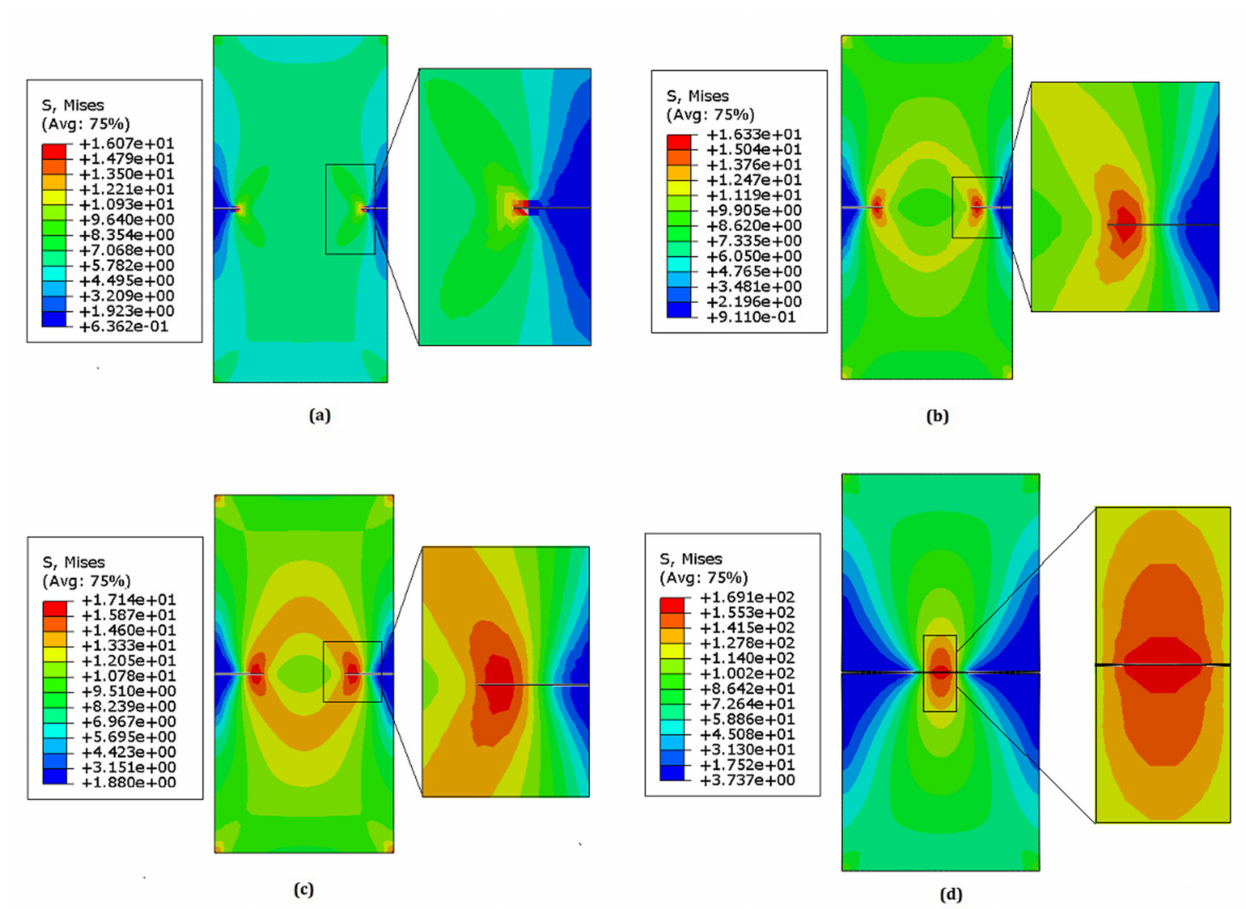
Figure 14. Von Mises stress distribution in double edge cracked specimen in ( a ) loading ( b ) crack initiation ( c ) crack propagation ( d )